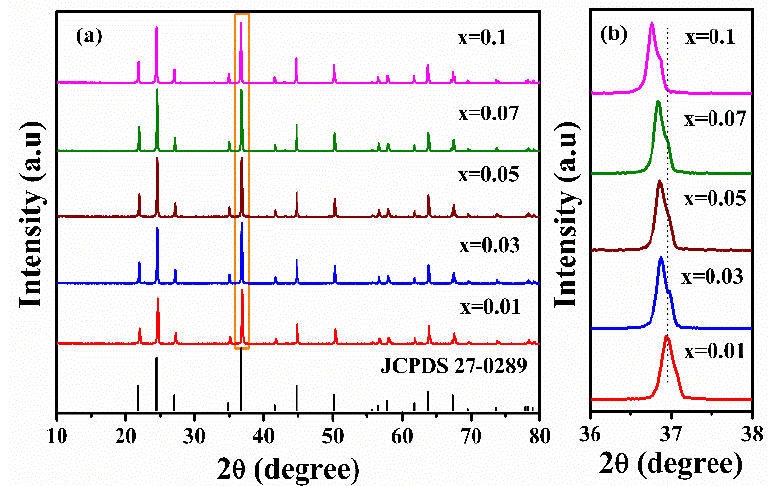
Figure 3. ( a ) X-ray powder diffraction (XRD) patterns of Li 2 CaGe 1−x Cr x O 4 (x = 0.01, 0.03, 0.05, 0.07, and 0.1) and the standard data of the Li 2 CaGeO 4 phase as a reference; ( b ) the magnified XRD curves in the range of 36°–38°.